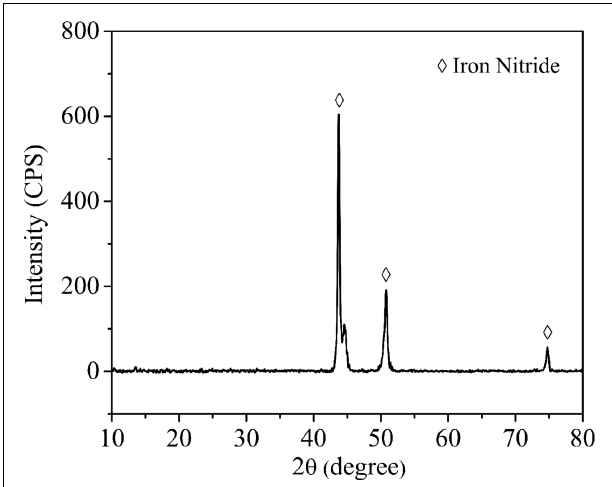
FIGURE 4 | X-ray diffraction (XRD) patterns of corrosion products on 304 SS surface after the 14-day incubation.